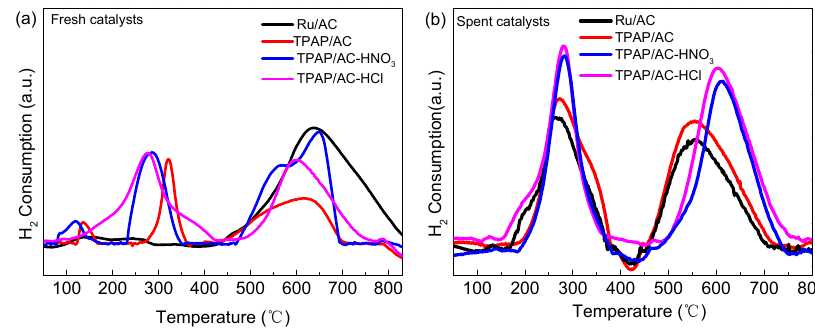
Figure 6. TPR profiles of the fresh ( a ) and spent ( b ) Ru ‐ based catalysts.